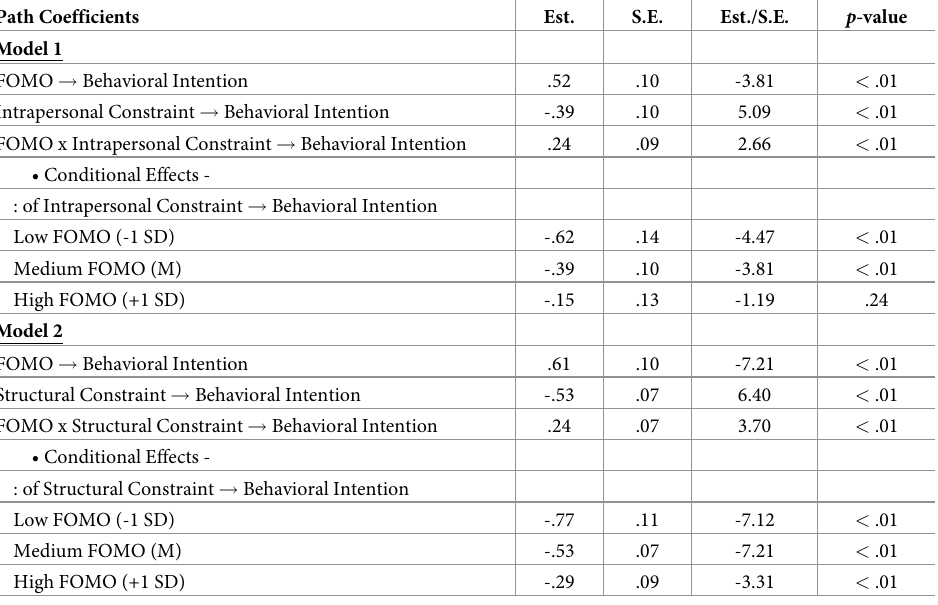
Table 4. Study 1: Path coefficients of the Structural